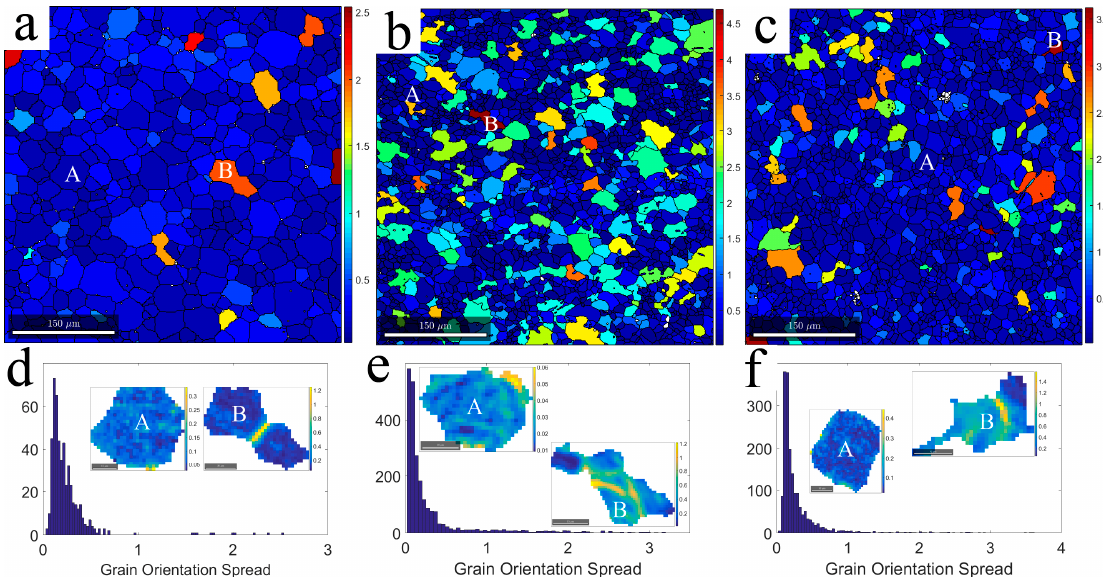
Figure 6. ( a – c ) grain-orientation spread (GOS) maps and ( d – f ) GOS distribution plots from ( a , d ) the initial state; ( b , e ) air-cooled; and ( c , f ) restrained air-cooled specimens. The color-code values are consistent with respective to GOS values, located on the right side of each map. Selected segmented grains (A, B) in each map are plotted using KAM analysis in the inset of each relevant GOS profile.